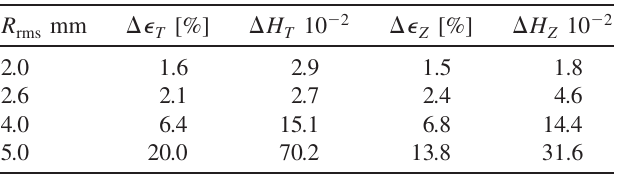
TABLE VI. Beam size dependence—Gaussian beam, v ¼ 340 kV .